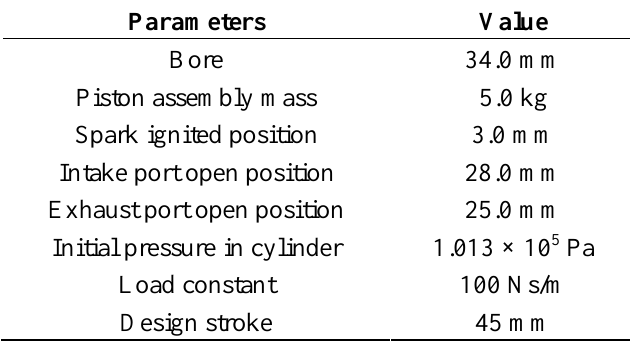
Table 1. Parts of key parameters of the single-piston engine